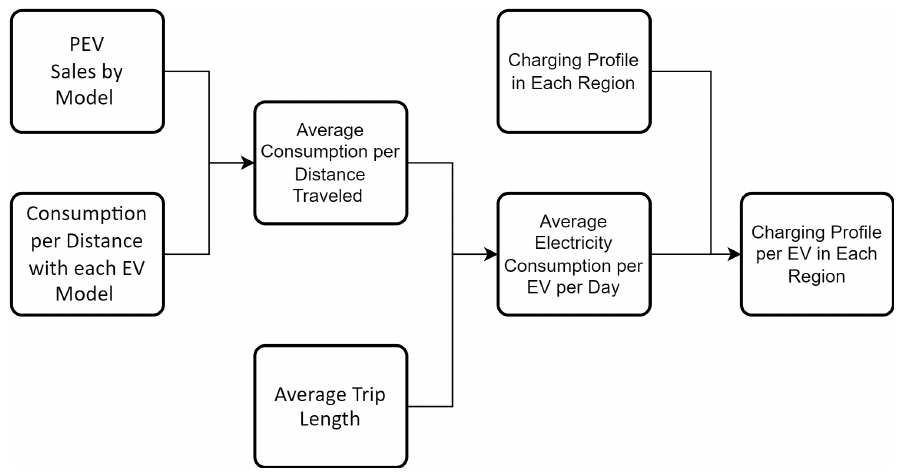
Figure 2. Evaluation of charging